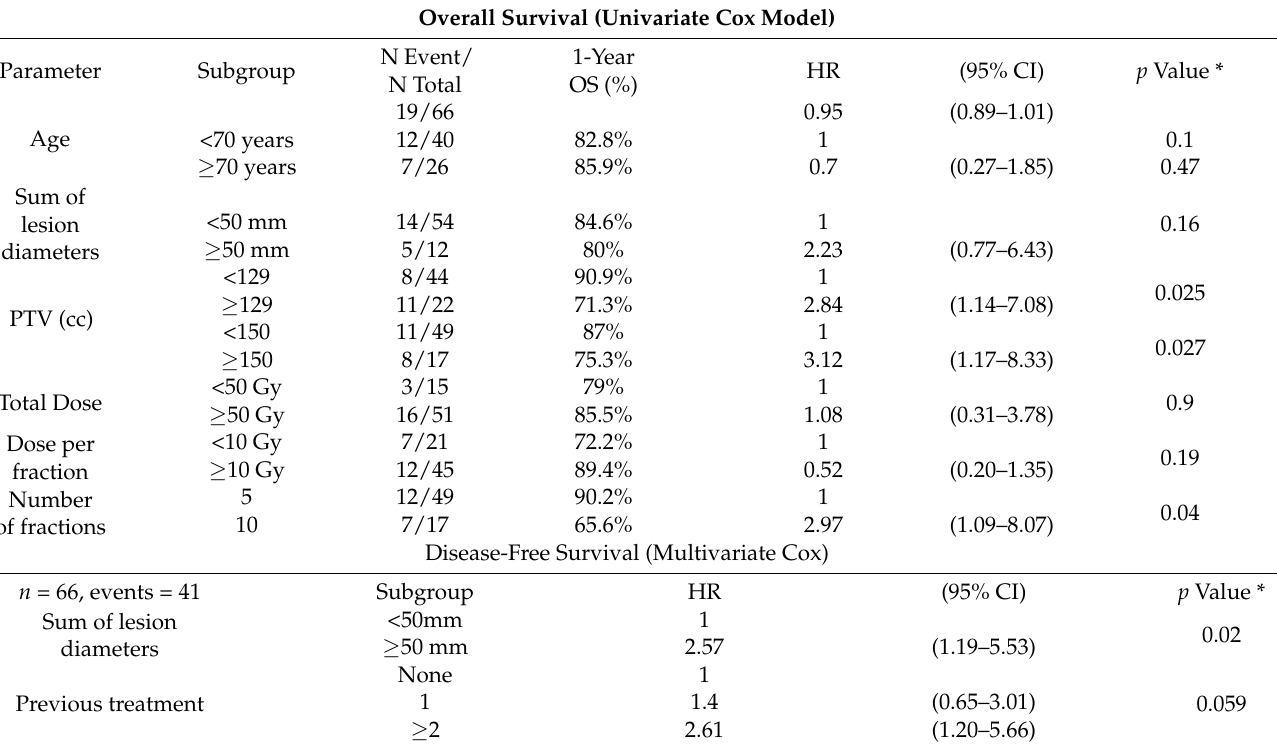
Table 5. Overall survival (univariate Cox model) and disease-free survival (multivariate Cox). Overall Survival (Univariate Cox